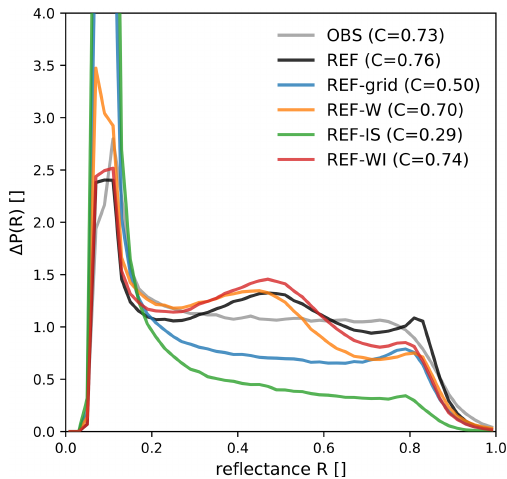
Figure 10. Differences between the 0.6µm SEVIRI solar re- flectance PDFs obtained for the reference run with modified op- erator settings and standard settings. The modified settings are switching off the cloud-top inclination, using random instead of maximum-random subgrid cloud overlap, including aerosols with an optical depth of 0.1 and changing the cloud ice particle habit to solid columns. For comparison, the difference between the observa- tions and the reference run histogram is also shown (dashed